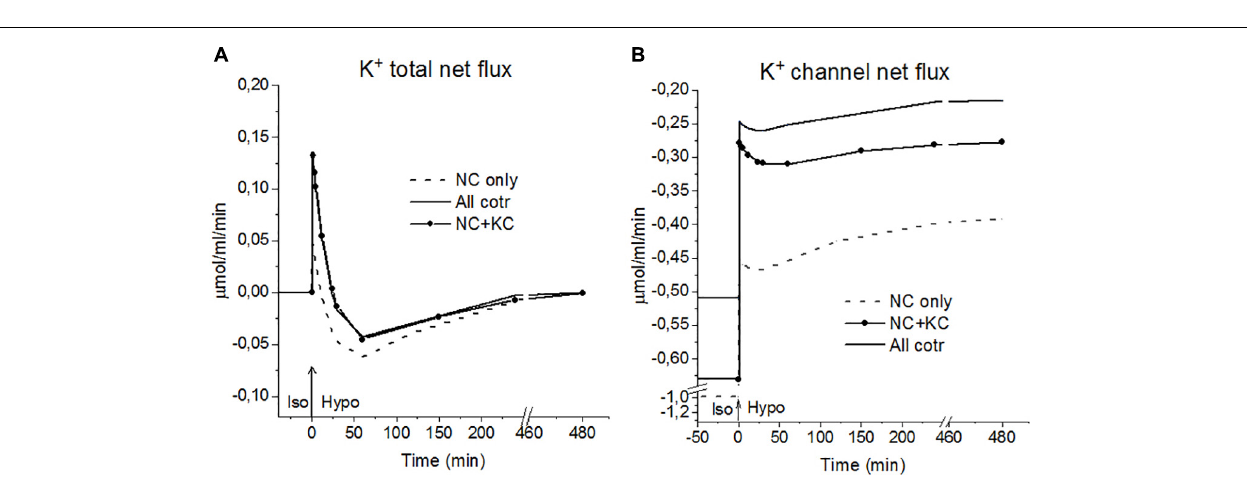
FIGURE 4 | Rearrangement of ionic homeostasis during transition to hypotonic medium with and without a decrease in NaCl concentration, calculated for a system with a full set of cotransporters (NC + KC + NKCC) at the unchanged over time parameters as in U937 cells, equilibrated with standard RPMI medium. The standard medium was replaced at t = 0 by (1) hypoosmolar medium of 160 mOsm obtained by removing 75 mM NaCl from standard isoosmolar medium, (2) isoosmolar medium of 310 mOsm, prepared by removing 75 mM NaCl and adding 150 mM sucrose instead, (3) a medium of 160 mOsm obtained by removing 150 mM sucrose from an isoosmolar medium without a decrease in NaCl concentration. The concentrations of Na + and Cl - in media (2) and (3) were 65 and 41 mM, respectively.